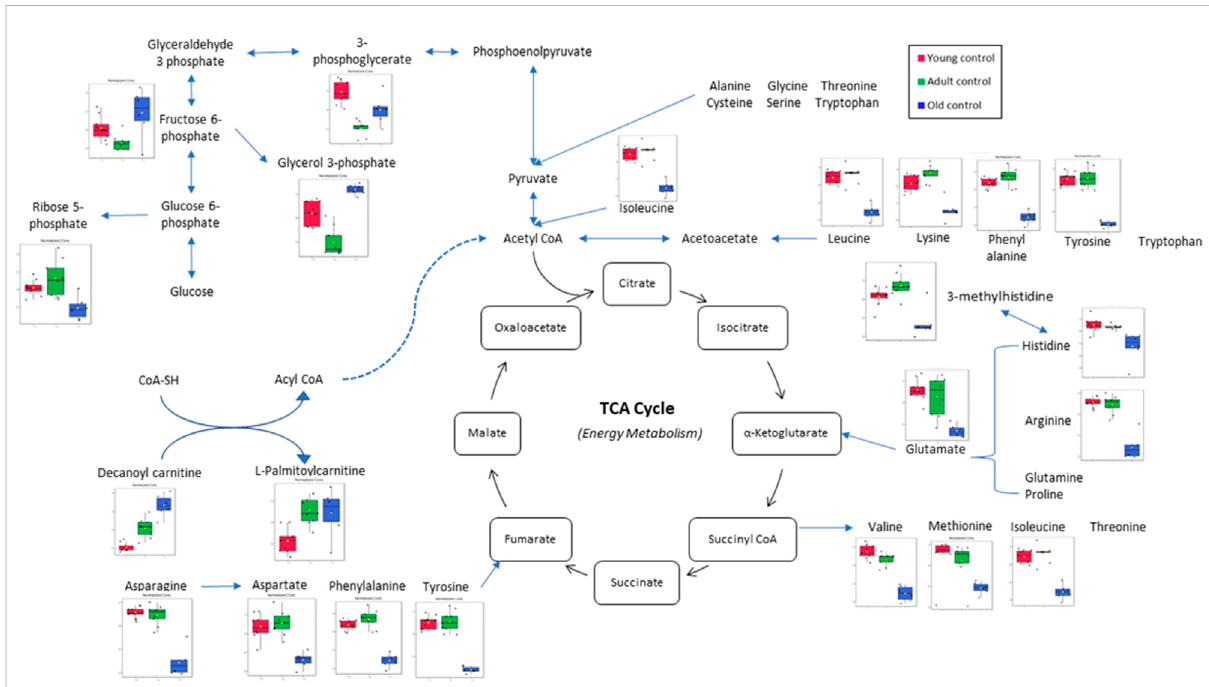
FIGURE 8 Muscle metabolomes changes in ageing rats. Metabolite concentrations in muscle specimens are depicted graphically and subjected to quantitative analysis. Box and whiskers plots with 95% con fi dence intervals are presented for quanti fi ed amino acids. Analysis was performed using one-way Anova with Tukey ’ s post hoc analysis. *p <